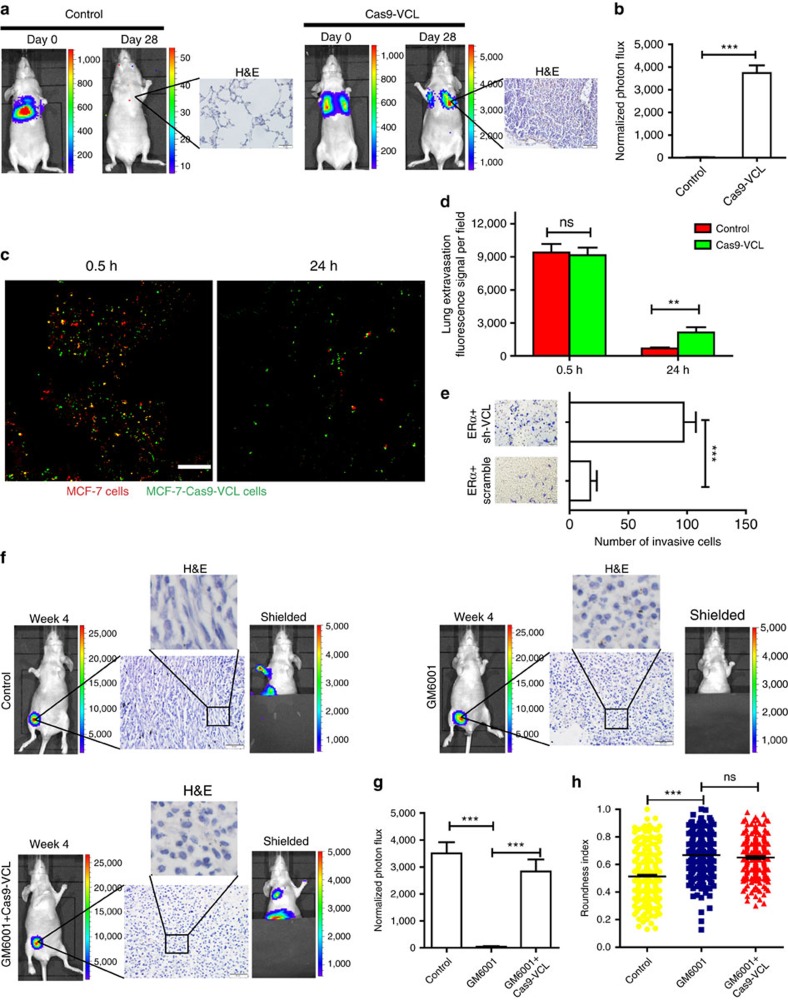
Vinculin downstream of ERα is important for metastasis.MCF-7-luc2 cells and CRISPR/Cas9-mediated VCL-deleted MCF-7-luc2 cells were injected into nude mice via the tail vein to generate xenografts (n=5). (a) Bioluminescence imaging of the control or the Cas9-vinculin group. Tumour formation in the lung was determined using H&E staining. (b) Luciferase counts in the lungs of mice on week 4. (c) Representative confocal images of mouse lungs 0.5 and 24 h after tail vein co-injection of control MCF-7 cells (red) and Cas9-vinculin MCF-7 cells (green). Scale bar, 100 μm. (d) Quantification of cells retained in the lung after tail vein injection (n=4 mice). (e) A transwell assay was performed in ERα-overexpressing MDA-MB-231 cells infected with lentivirus containing vinculin short hairpin RNA (shRNA; sh-VCL) or scrambled RNA (scramble; n=3). Control MDA-MB-231-luc2 cells, GM6001-treated control cells or GM6001-treated and CRISPR/Cas9-mediated VCL-deleted MDA-MB-231 cells were injected into nude mice to generate xenografts (n=5). (f) Representative bioluminescence images of different groups on week 4 are shown. The cell morphology of the primary tumour was determined by H&E staining. Scale bar, 50 μm. The particular section of H&E image was enlarged to highlight the cell morphology. (g) Luciferase counts of metastasis sites on week 4. (h) Roundness index of corresponding MDA-MB-231 cells from the primary tumour in f (n=200 cells). (b,d,e,g,h) The data are shown as the mean±s.e.m. ns P>0.05, **P<0.01, ***P<0.001. (b,d,e) Unpaired t-test; (g,h) ANOVA with Tukey's post hoc test.